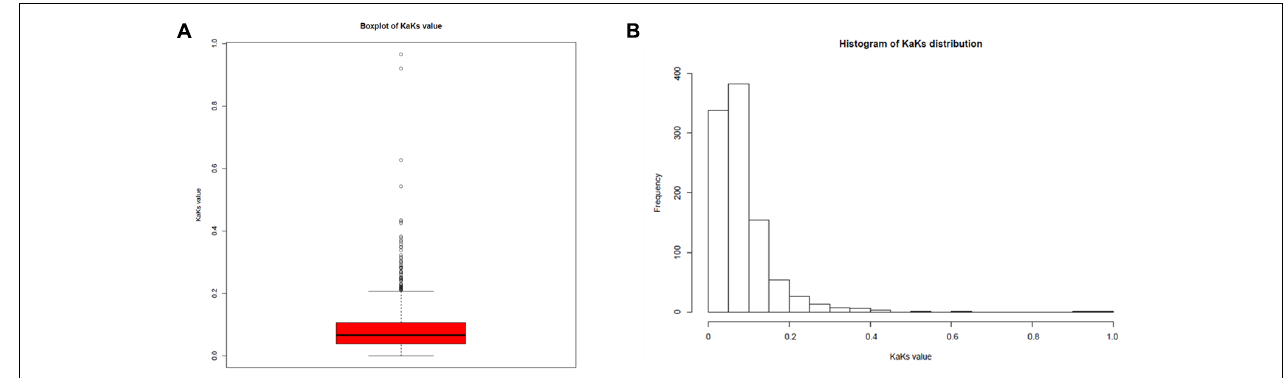
FIGURE 5 | K a /K s values for each gene. (A) Boxplot of K a /K s values; (B) distribution of K a /K s values.